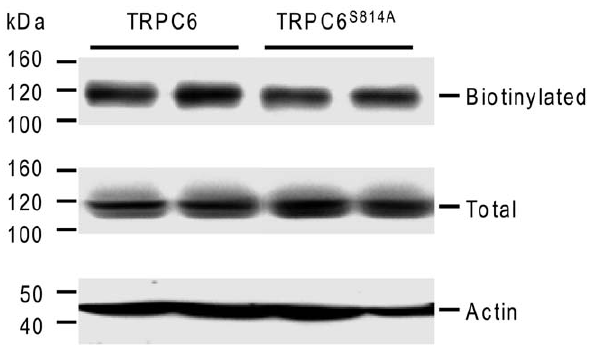
Figure 4. The mutation of Ser 814 into Ala does not modify the level of expression nor the trafficking of TRPC6. TRPC6 and TRPC S814A were transfected in HEK293T cells. The cells were biotinylated with sulfo-NHS-SS-biotin, lysed, and incubated with streptavidin- agarose beads as described in Experimental Procedures. Proteins precipitated by streptavidin-agarose were separated by SDS-PAGE and detected with an anti-HA antibody ( top ). Aliquots of the cell lysates were collected before the incubation with streptavidin-agarose and analyzed directly by immunoblotting to determine the total amount of TRPC6 ( middle ) and actin (bottom) in the samples. Representative